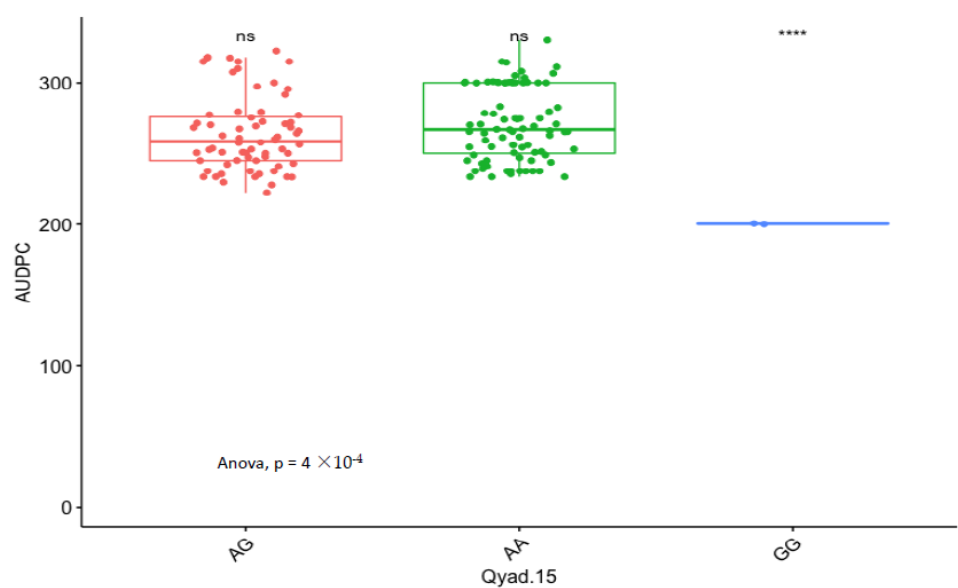
Figure 5. Comparison of the effects of the different alleles (variants) of Qyad-15 on the AUDPC estimates in the study population. The letters on the X-axis represent alleles (AA, AG, and GG), *** statistical significance at p values 0.0001 while ns is non-significant